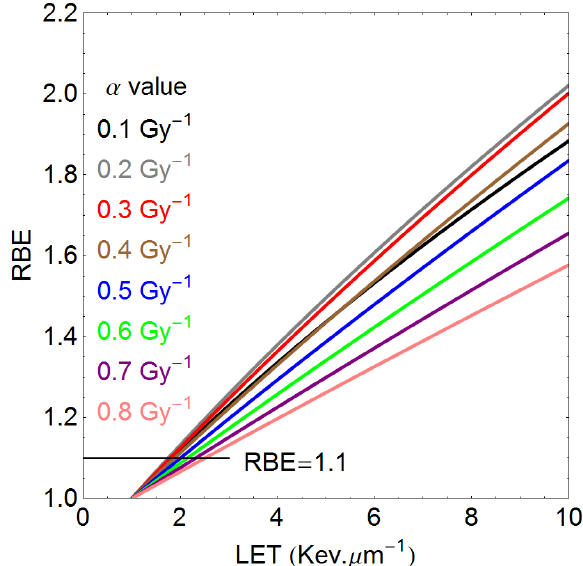
Figure 6. Relationship between LET and RBE, for variable low LET α values (Gy −1 ), as shown by the colour codes. The low LET β value is 0.035 Gy −2 , increasing with LET. The change in the RBE rank order at lower values of α is due to the higher preponderance of β related cell kill at low α